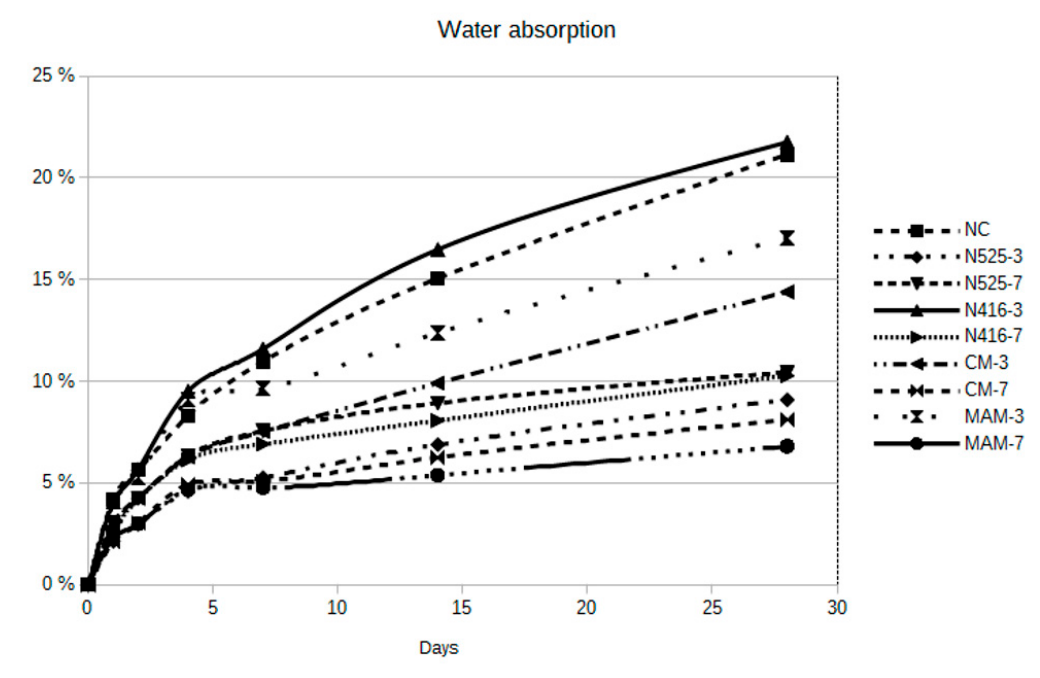
Figure 4. Water absorption, in weight-%. Time in days.